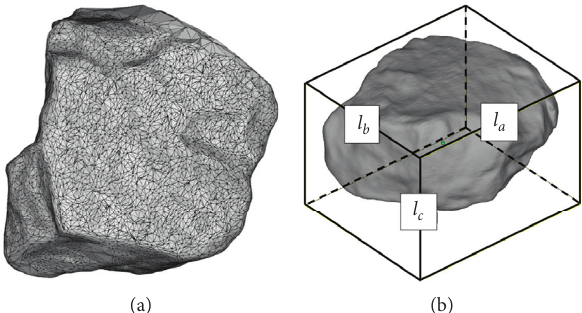
Figure 3: Calculation of the shape index parameters: (a) triangular meshing of the surface; (b) circumscribed triaxial ellipsoid of the aggregate.